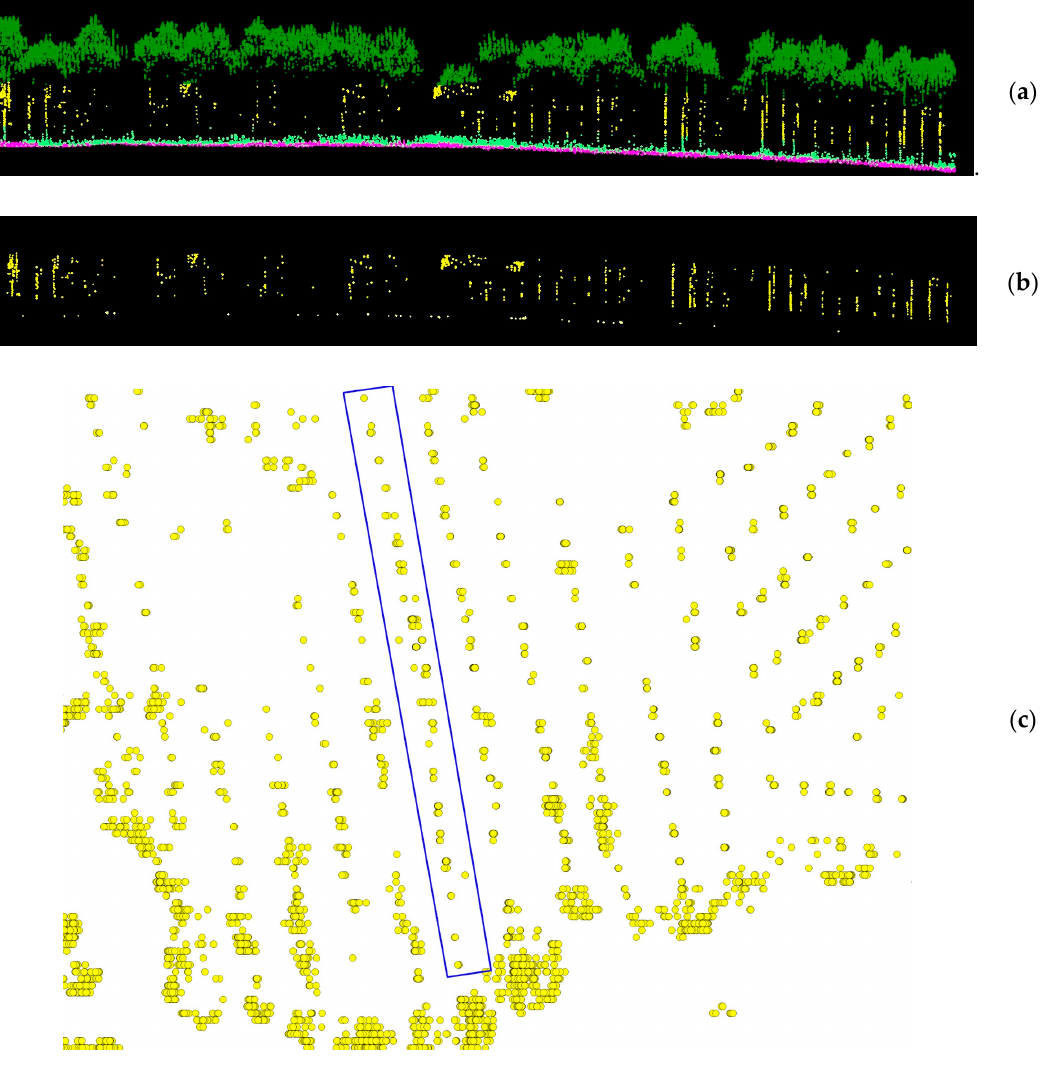
Figure 3. Extraction of the stem layer in a sample row of trees: ( a ) point cloud; ( b ) stem layer extraction from the point cloud; ( c ) horizontal projection of the extracted layer.